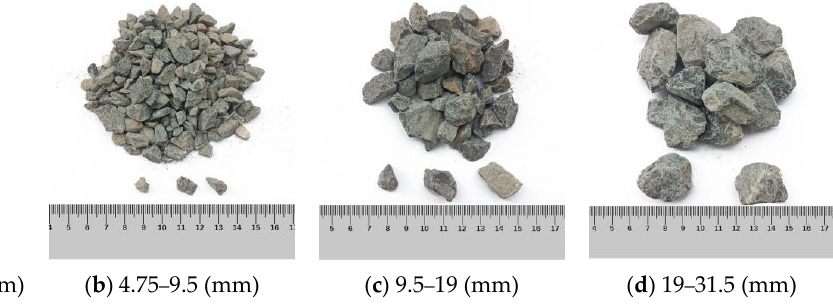
A A A (c) XRD spectrums of crushed stone Figure 6. Microstructure of crushed stone.